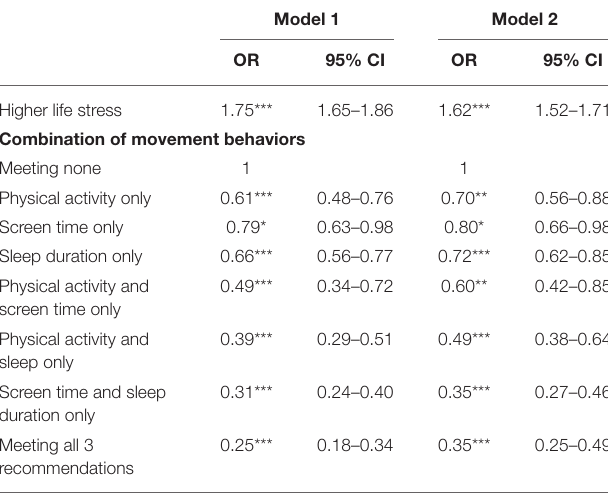
TABLE 4 | Results of the ordered logistic regression analysis of the association of meeting different combinations of movement behavior recommendations with self-esteem independent of life stress among adolescents ( N =